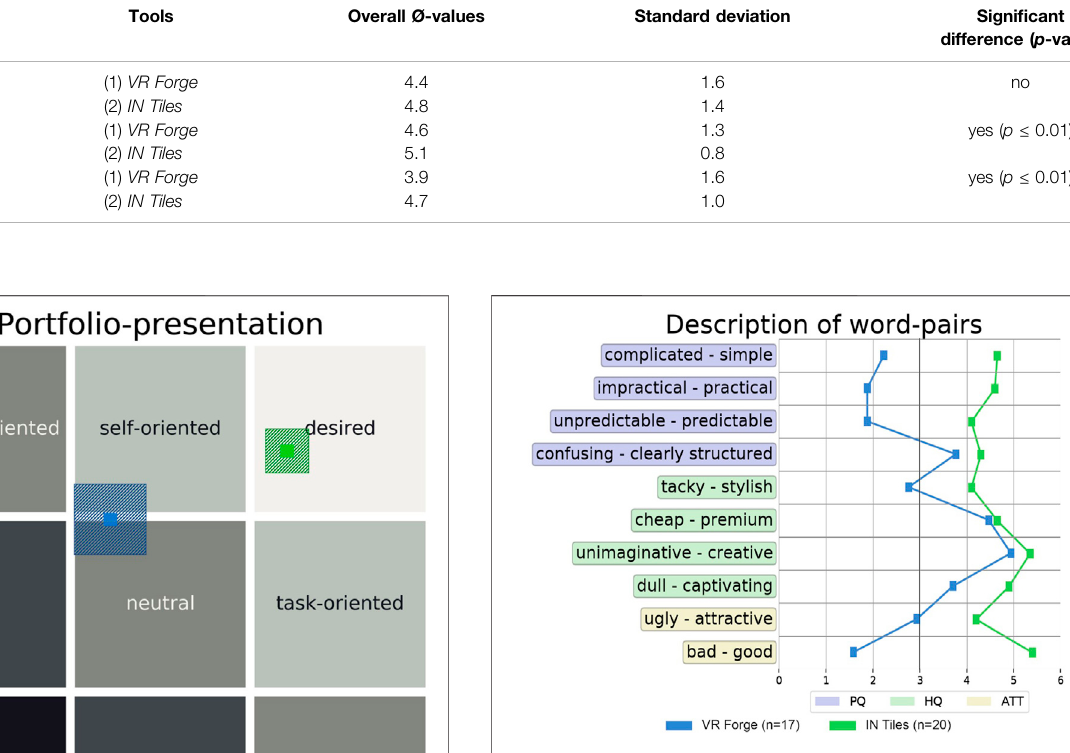
FIGURE 14 | Word-pair visualization of the mean values of the AttrakDiff questionnaire for the evaluation of VR Forge (blue) and IN Tiles